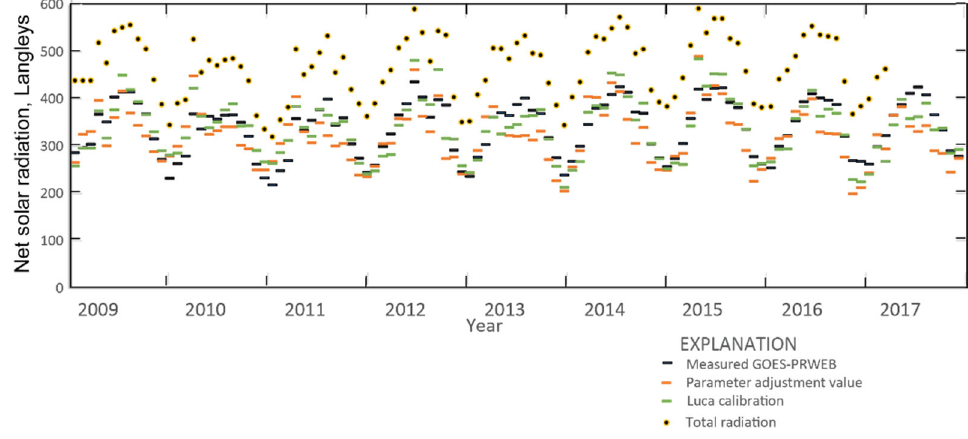
Figure 11. Monthly average solar radiation in manual calibration, Luca calibration, and measured data.